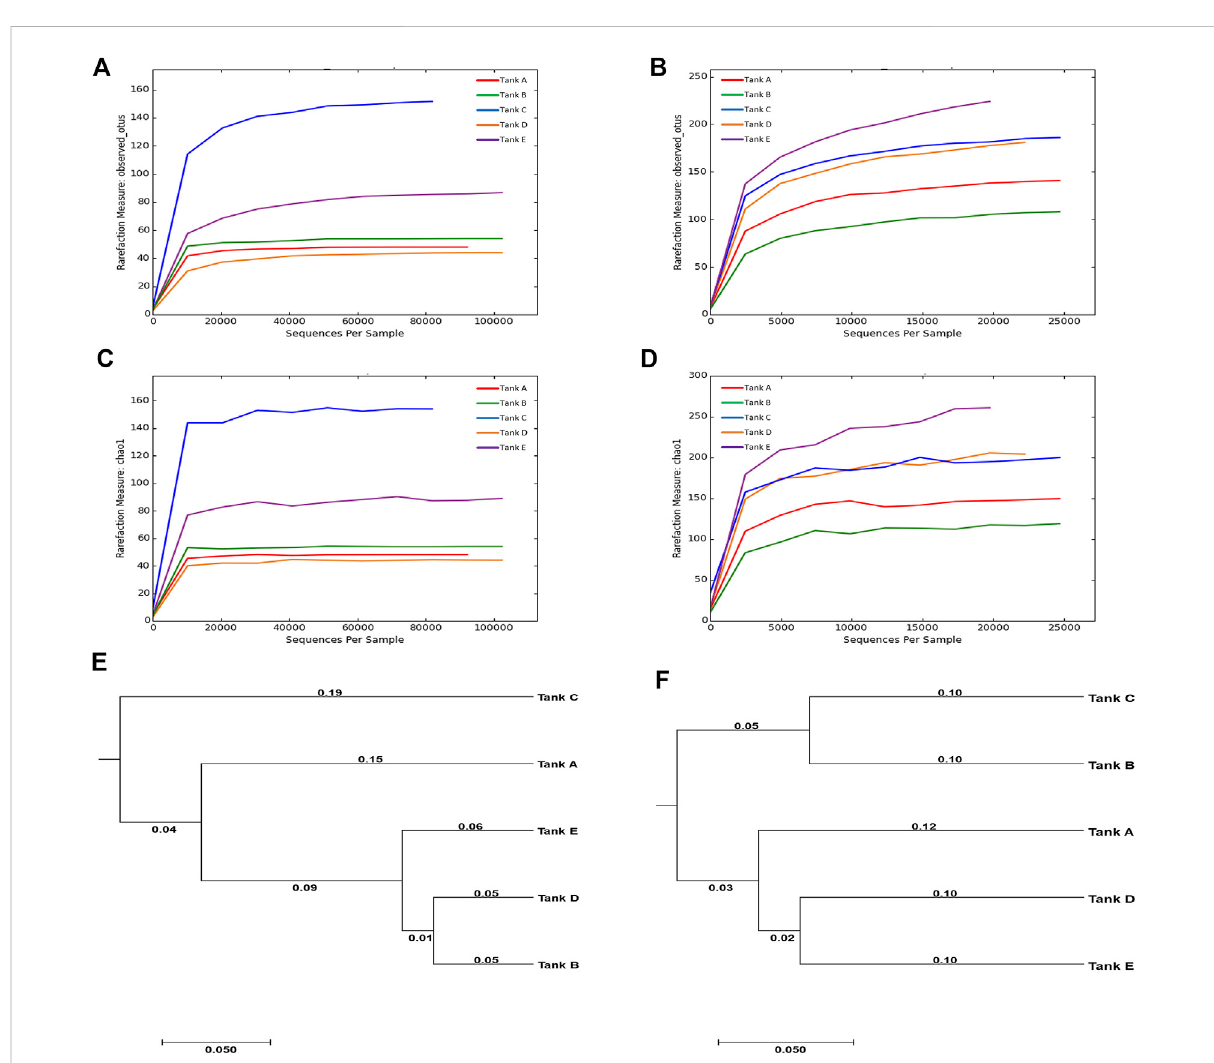
FIGURE 2 Rarefaction curves and UPGMA trees calculated from the fi ve tanks. (A – D) Rarefaction curves are for OTUs and species richness (Chao1). The OTUs were analyzed using CD-HIT program at 97% sequence similarity, and the rarefaction curves and diversity indices for OTUs and Chao1 were computed using the mothur platform. (E,F) The relationships among the microbial community diversities for the fi ve tanks. The UPGMA trees were formed using the weighted UniFrac distance. [For eukaryotic microbial communities: rarefaction curves of (A) OTUs and (C) Chao1, and (E) UPGMA tree. For prokaryotic microbial communities:rarefaction curves of (B) OTUs and (D) Chao1, and (F) UPGMA tree]. The data underlying all the graphs indicated in this fi gure can be found in the Supplementary Table